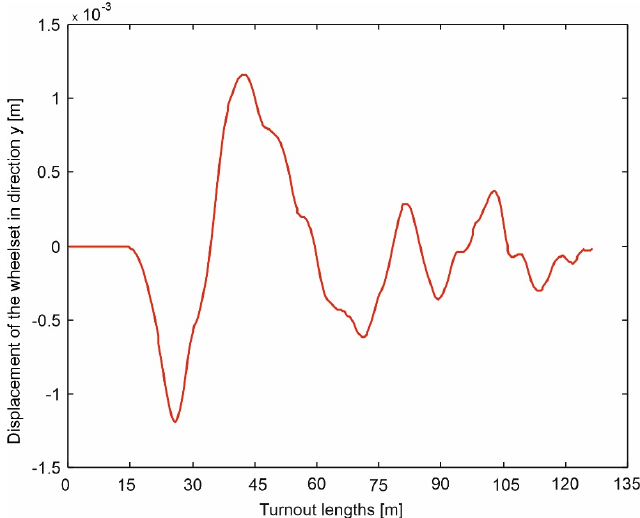
Figure 11. Displacement of a wheelset in y direction determined for a train crossing the turnout on a straight track with a speed of v = 200 km/h.